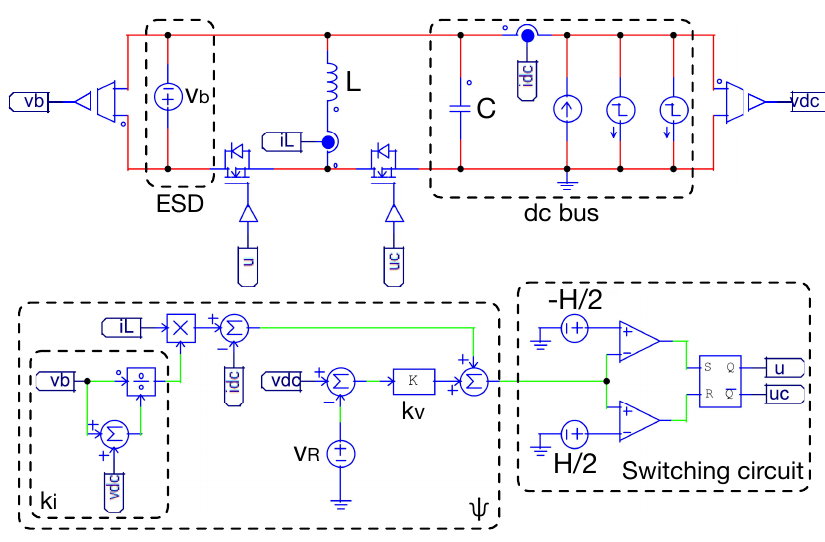
Figure 4. Simulation scheme implemented in PSIM software.